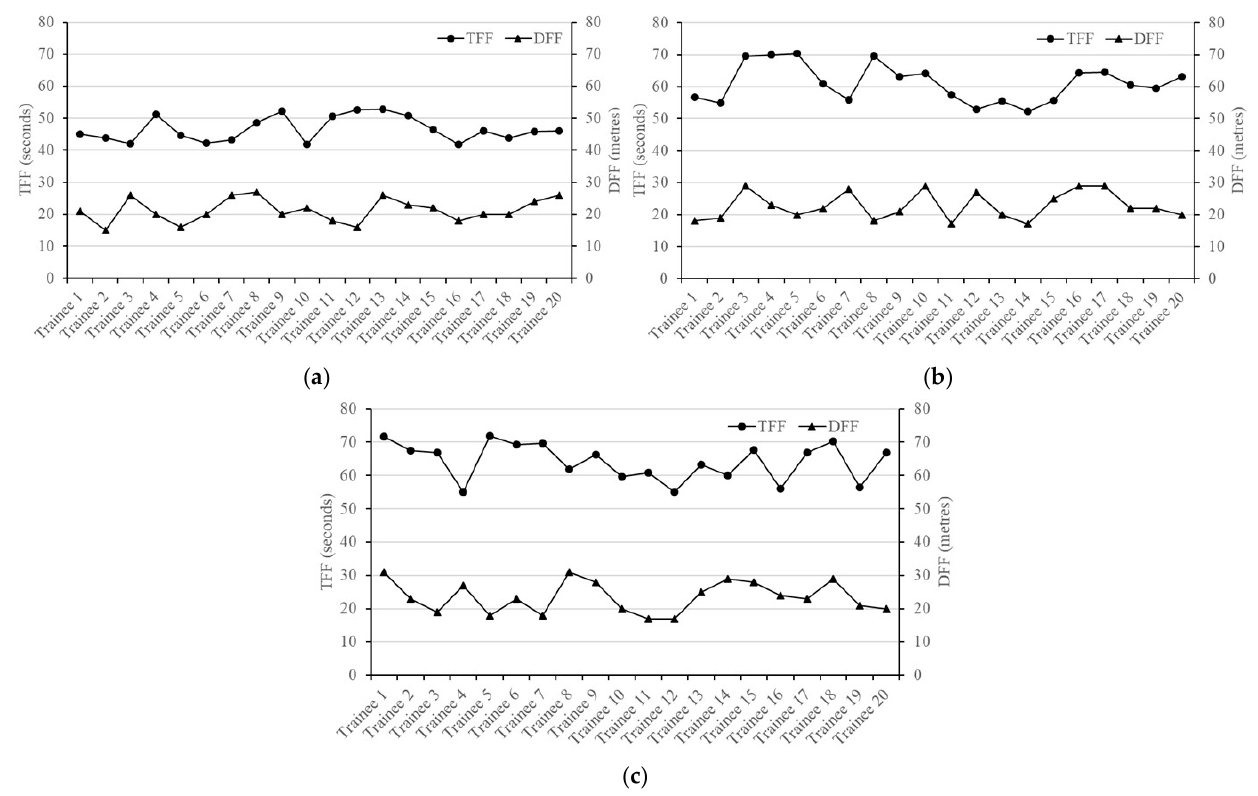
Figure 14. Comparison of individual driver responses based on the TFF and DFF under the driving condition at: ( a ) morning, ( b ) night and ( c ) evening. condition at: ( a ) morning, ( b ) night and ( c ) evening. Table 3. Average TFF and DFF values for all hazard scenarios under all driving